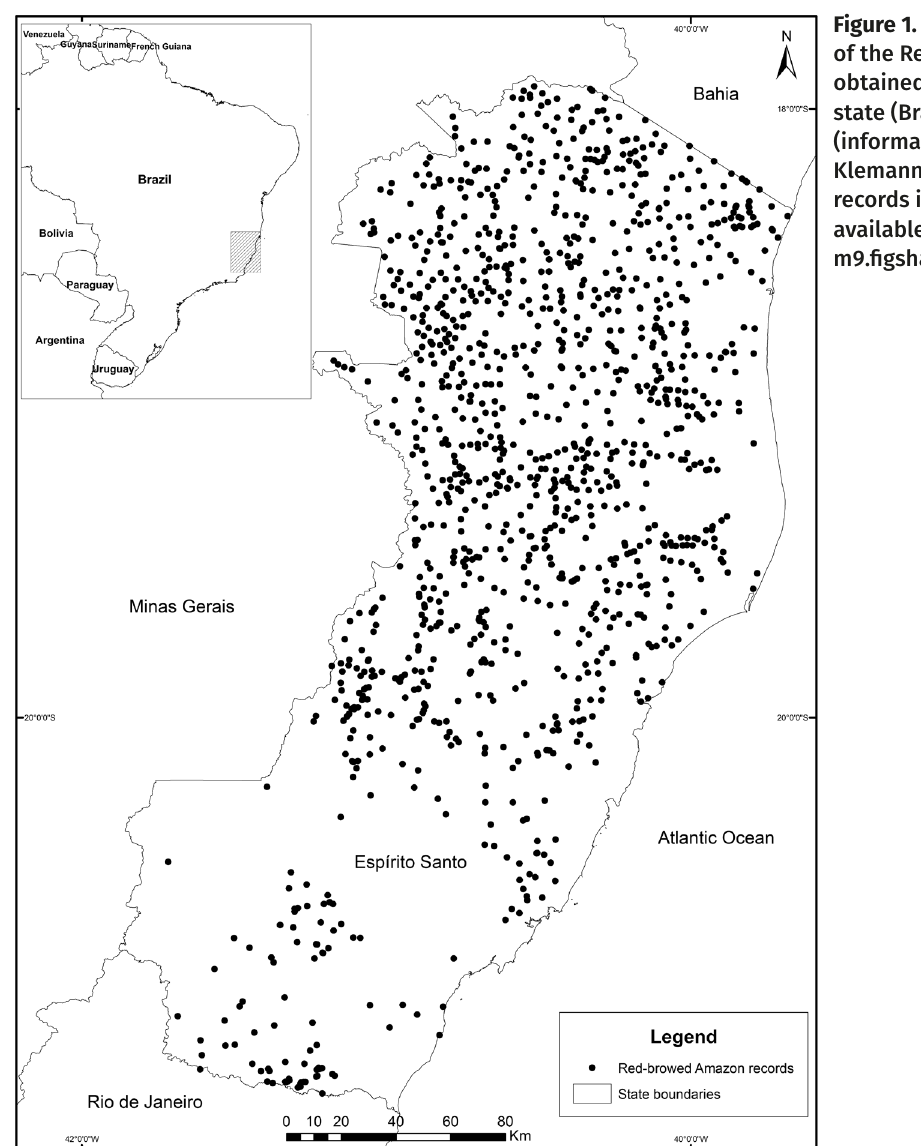
Figure 1. Points of occurrence of the Red-browed